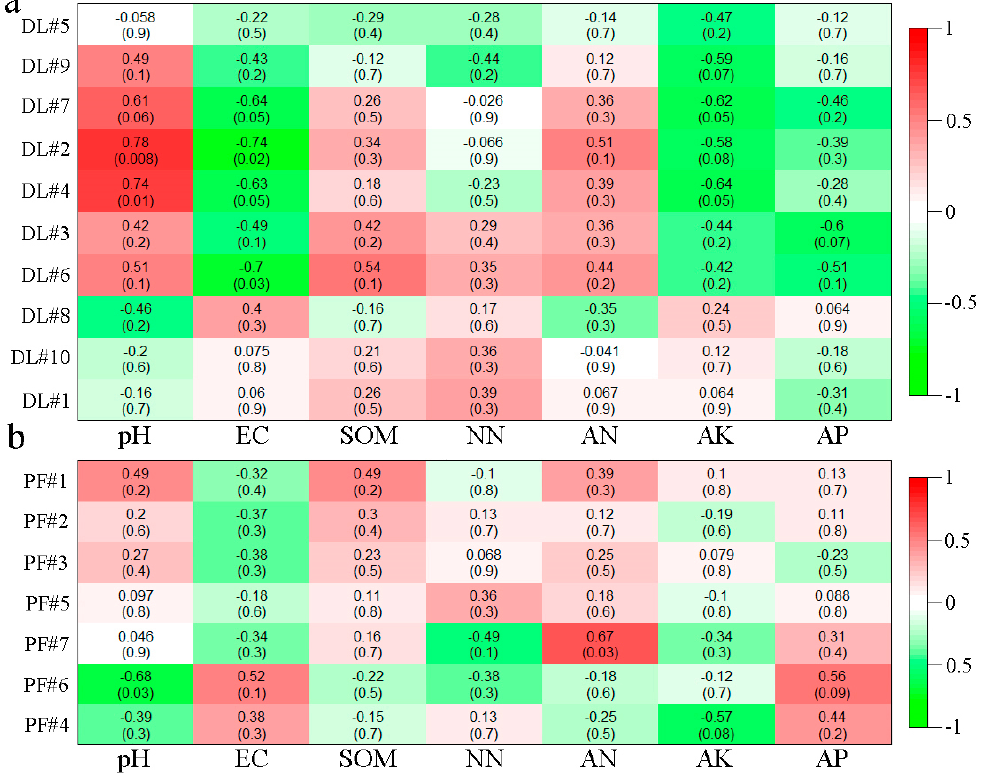
Figure 7. Heatmap analysis of bacteria module correlations with environmental factors in DL ( a ) and PF ( b ).